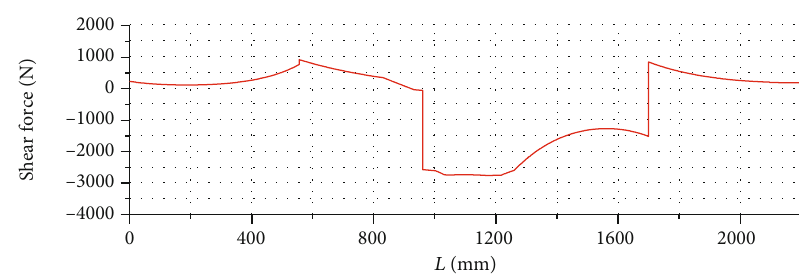
Figure 6: Shear force diagram when the gross load is 130 MPa.